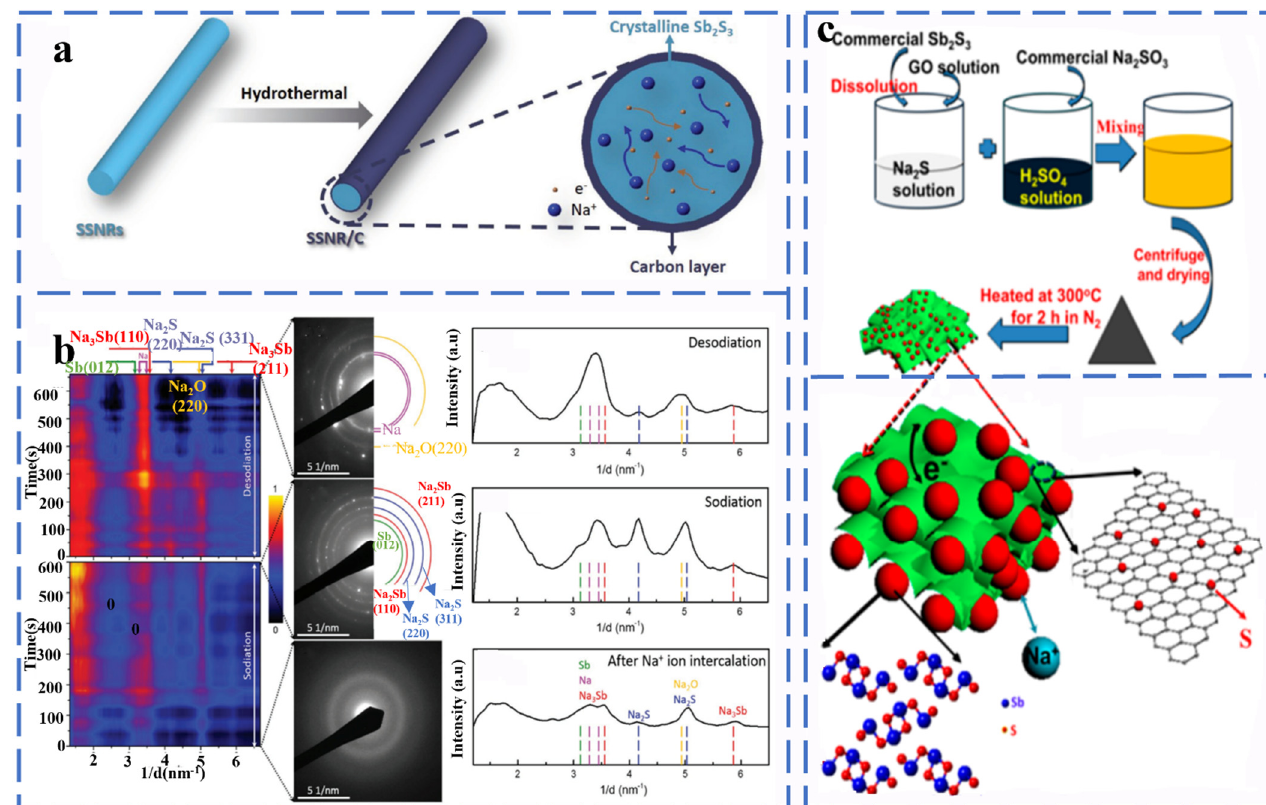
Figure 5. ( a ) Schematic representation of the synthesis process of SSNRs and SSNR/C nanocomposite, ( b ) Phase evolution during the first sodiation and desodiation processes of SSNR/C electrode probed by in situ electron diffraction. Reprinted with permission from Ref. [51]. Copyright 2020, copyright Wang, P. ( c ) Schematic illustration of the fabrication process of the Sb 2 S 3 /SGS composite. Reprinted with permission from Ref. [52]. Copyright 2018, copyright Zhao, Z.